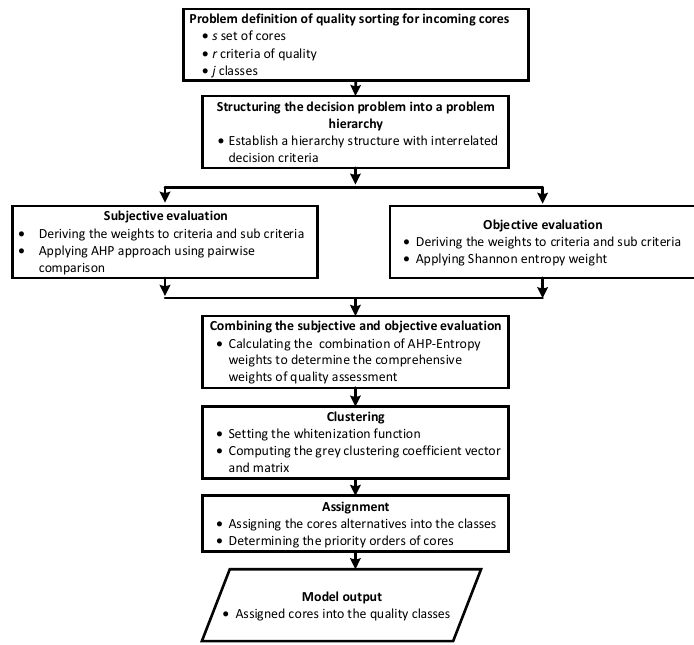
Figure 2. Major steps of the proposed